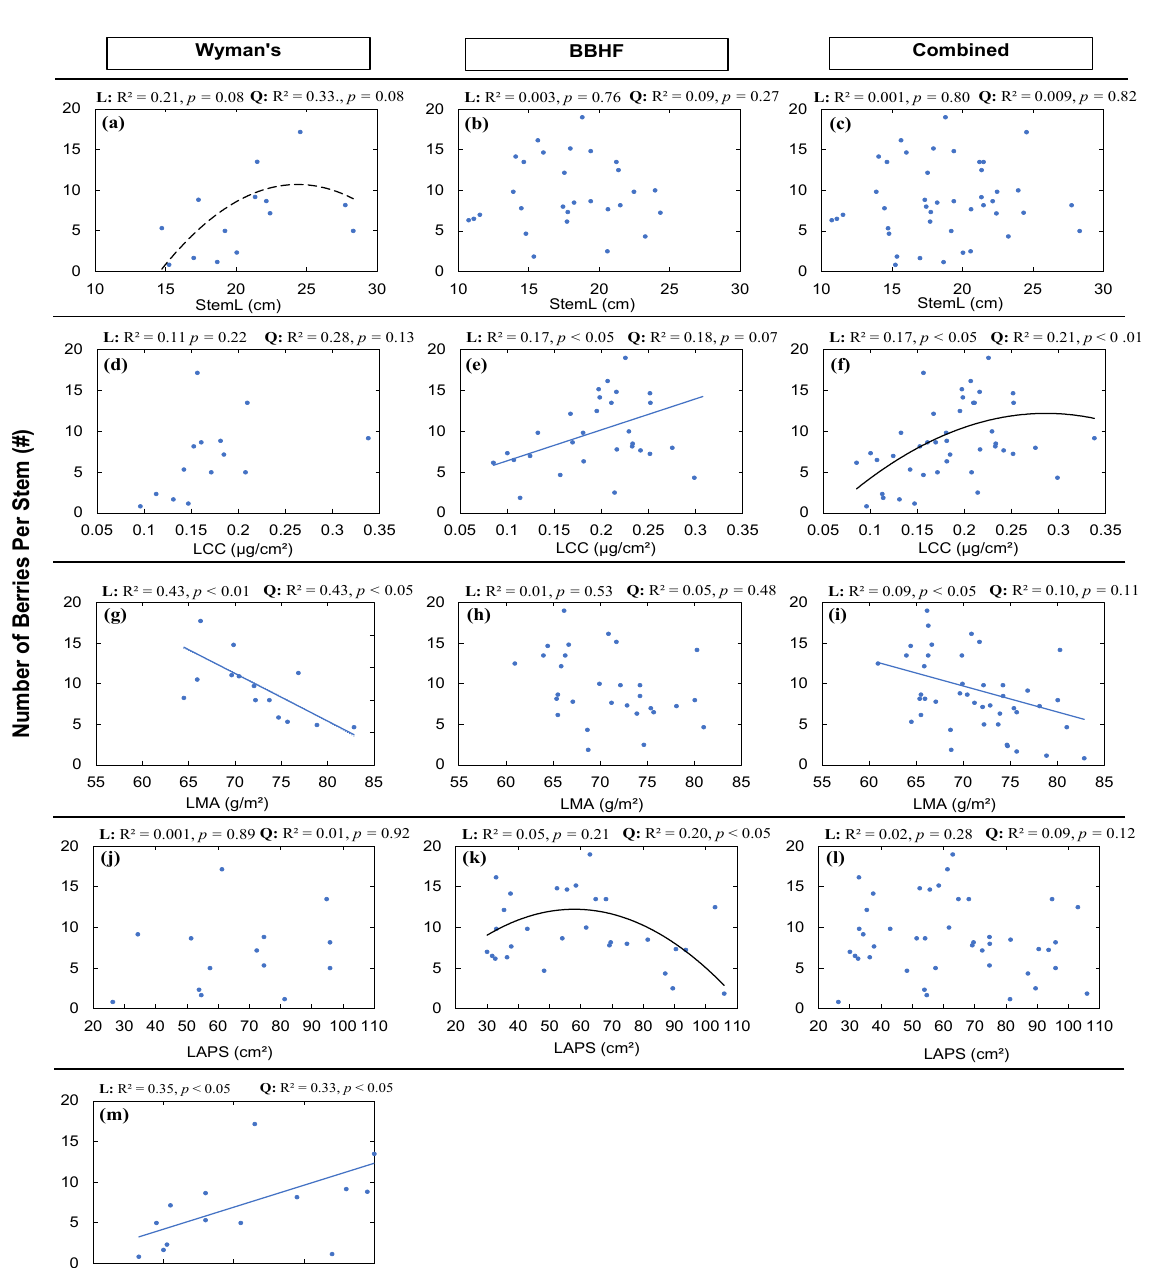
Figure 5. Average number of berries per stem (NBS) in wild blueberry fields in relation to average stem length (StemL) ( a – c ); average leaf chlorophyll concentration (LCC) ( d – f ); average leaf mass per area (LMA) ( g – i ); average leaf area per stem (LAPS) ( j – l ); and average soil temperature (SoilT) ( m ). The solid blue lines indicate significant ( p < 0.05) linear relationships, and black lines indicate significant ( p < 0.05) quadratic relationships. Dashed lines indicate marginally significant ( p < 0.10) relationships. Here, among all the structural and functional traits, only significant or marginally significant relationships to NBS were plotted. The strongest relationship was selected from the high level of significance ( p - value) and higher coefficient of determination (R²).